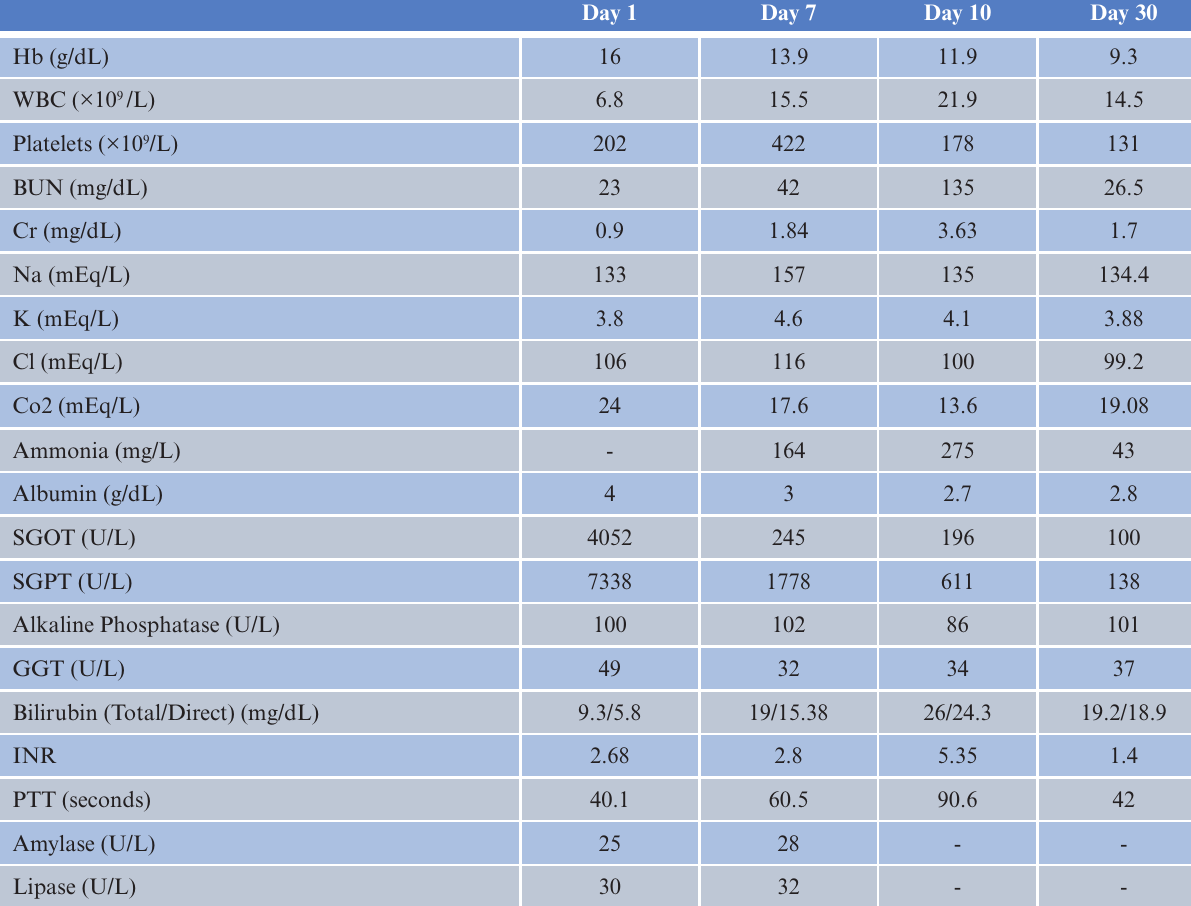
Table 1: Summary of laboratory values follow-up, during and after hospitalization